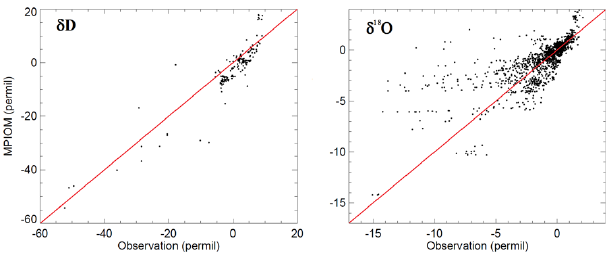
Fig. 4. Comparison of observed water isotopic values (averaged onto the MPIOM model grid) versus modelled surface isotopic val- ues. The 1:1 line is colored in